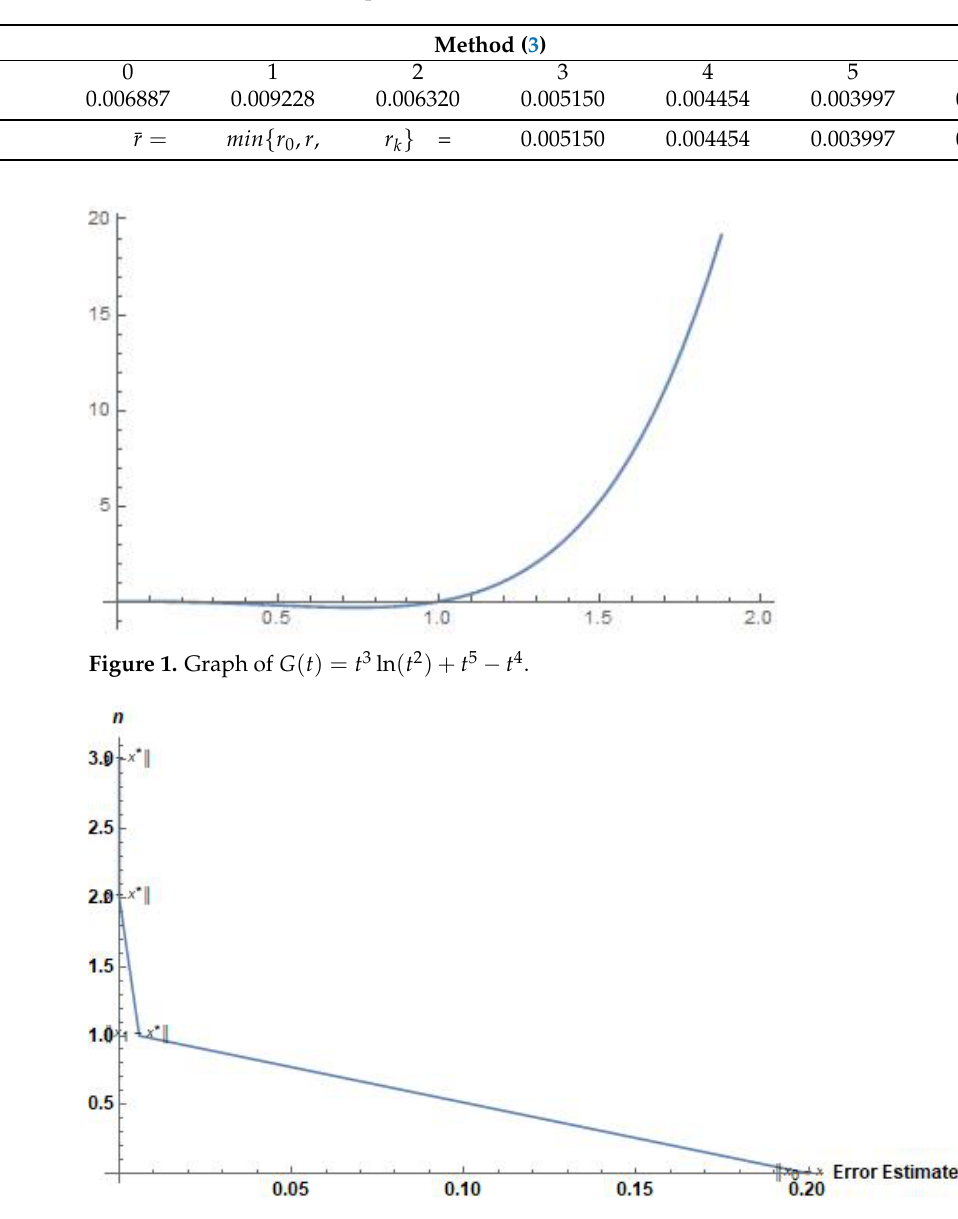
Figure 2. Error estimates for Example